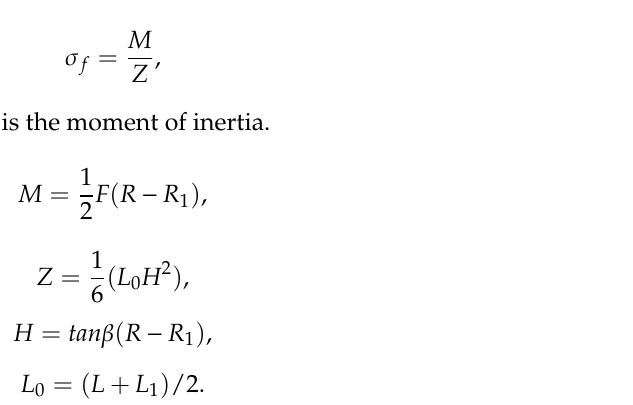
Figure 18. Schematic diagram of stress damage of cutting tool.